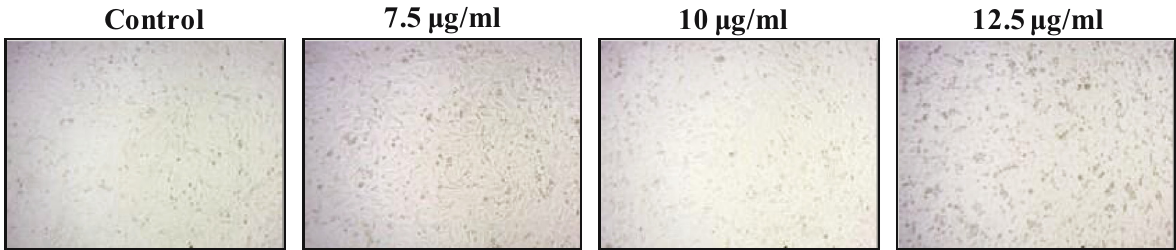
Figure 7: Morphological alterations in MDA - MB - 231 cells treated with ZnO NPs.